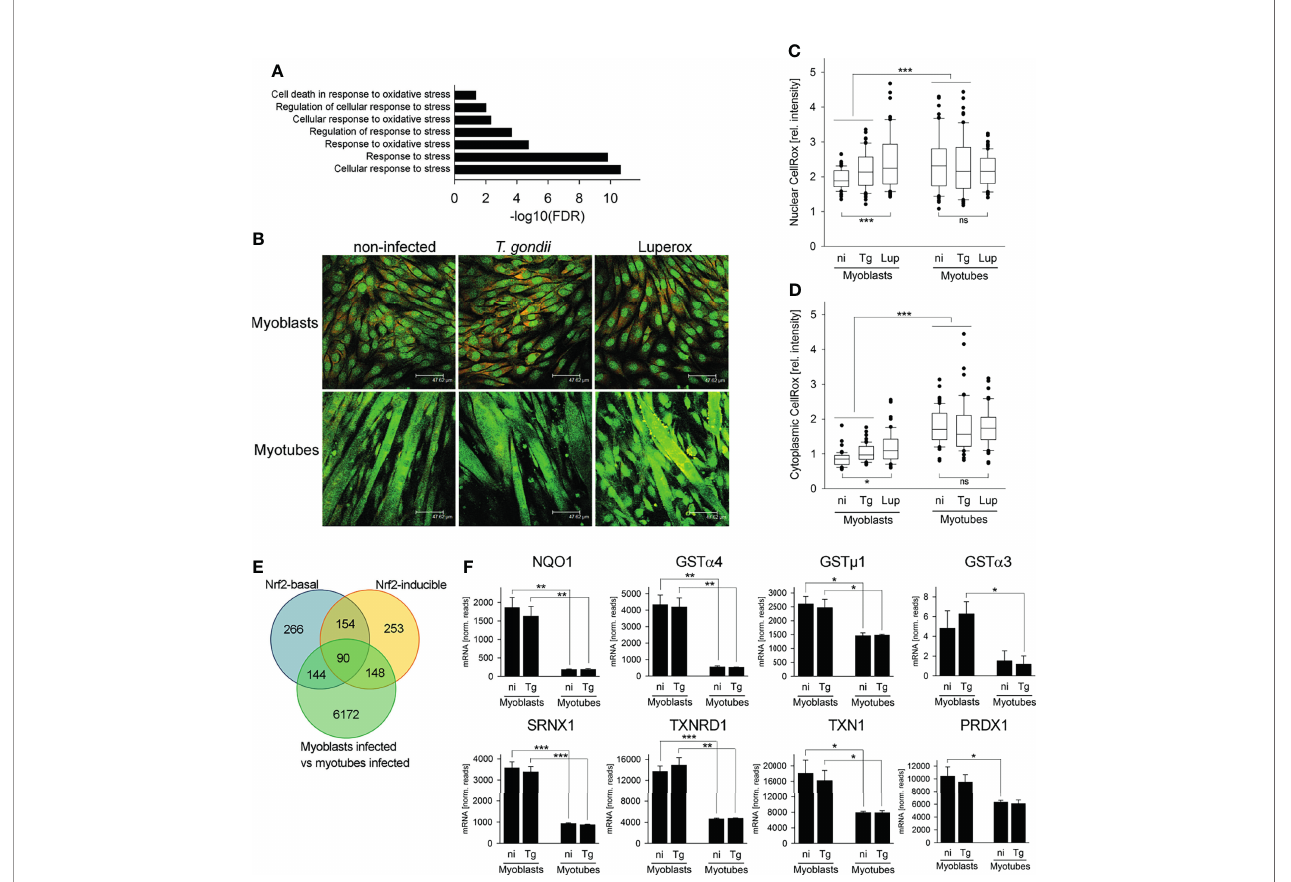
FIGURE 6 | The cellular redox homeostasis and Nrf2-dependent stress responses differ between myoblasts and myotubes during infection with T. gondii . C2C12 myoblasts and in vitro -differentiated myotubes were infected with T. gondii for 24 or 48 hours or were left non-infected. (A) RNA isolated at 24 hours after infection or from non-infected controls was used for high-throughput mRNA sequencing as described in Figure legend 1. DEGs identi fi ed between infected myoblasts and myotubes were analyzed for signi fi cantly enriched GO terms which are related to the stress response. Results are from three biological replicates. (B – D) At 48 hours after infection, ROS were labelled in live cells using a fl uorogenic CellROX ™ oxidative stress probe (green). Note that the CellROX ™ Green reagent upon oxidation binds to DNA, and the signal is therefore primarily localized in the nucleus and in mitochondria. After fi xation, cells were additionally labelled by propidium iodide (red). As a positive control, non-infected myoblasts and myotubes were partially treated with tert-butyl peroxide (Luperox) for 1 hour before ROS staining. (B) Representative images were recorded by confocal laser scanning microscopy. (C, D) CellROX ™ Green intensities from nuclear (C) and cytoplasmic (D) regions were recorded from confocal laser scanning microscopic images and were normalized to PI intensities from the same regions. Data are from 60 individual cells each of non-infected (ni), T. gondii -infected (Tg) or Luperox (Lup)-treated cells from 3 independent experiments. Signi fi cant differences were identi fi ed by ANOVA (* p < 0.05; *** p < 0.001; ns, not signi fi cant). (E) Constitutive and inducible direct target genes of the stress-related transcription factor Nrf2 [Nrf2-basal or Nrf2-inducible, respectively (Malhotra et al., 2010)] were compared with DEGs between T. gondii -infected myoblasts and myotubes as identi fi ed by RNAseq described in Figure legend 1. (F) Expression levels of NAD(P)H dehydrogenase (quinone 1; NQO1), glutathione S-transferases (GSTs) a 4, µ1 and a 3, sul fi redoxin 1 homolog (SRNX1), thioredoxin reductase 1 (TXNRD1), thioredoxin 1 (TXN1) and peroxiredoxin 1 (PRDXN1) were extracted from the RNAseq data sets and are depicted as means ± S.E.M. from three biological replicates. Signi fi cant differences were identi fi ed by Student ’ s t -test (* p < 0.05; ** p < 0.01; *** p <